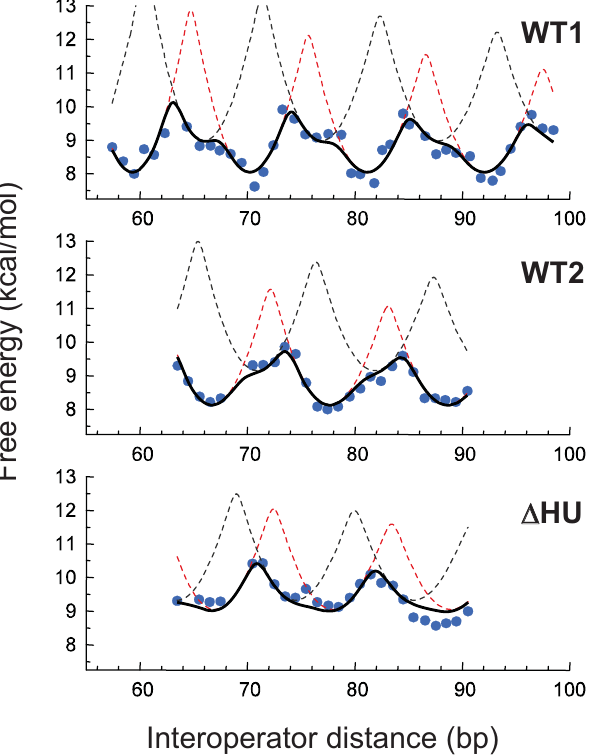
Figure 2. Two-conformation analysis of the in vivo free energy of DNA looping. The in vivo free energy of looping DNA by the lac repressor (blue symbols) was obtained as described in Saiz et al. [10] (see also Methods) from the measured repression levels of Muller et al. [11] for wild type (WT1) and of Becker et al. [22] for wild type (WT2) and a mutant that does not express the architectural HU protein ( D HU). As repression levels in the absence of looping (see Methods and Saiz et al. [10]) we have used 135 (WT1), 2.3 (WT2), and 1.7 ( D HU). The thick black continuous lines correspond in each case to the best fit to the free energy D G l given by Equations 1 and 2, which considers the contributions of two looped con- formations. The contributions of each conformation are shown ? e { D G 1, n = RT ) ) and black separately as red ( D G 1 ~{ RT ln( P ? n ~{ ? e { D G 2, n = RT ) ) dashed lines. The values of the ( D G 2 ~{ RT ln( P n ~{ ? parameters for the best fit are shown in Table 1.